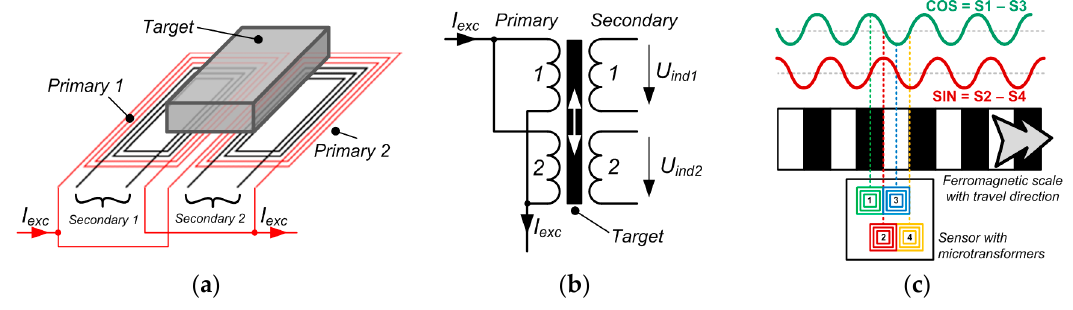
Figure 1. ( a ) The basic operation of the presented microsystem, consisting of two integrated microtransformers and a movable conductive and/or ferromagnetic target affecting the voltage induction between primary and secondary windings; ( b ) The schematic representation of a microtransformer pair; ( c ) The quadrature output signals are generated by moving a grating measurement scale over the microtransformer pairs. Sinusoidal signal shape is assumed.